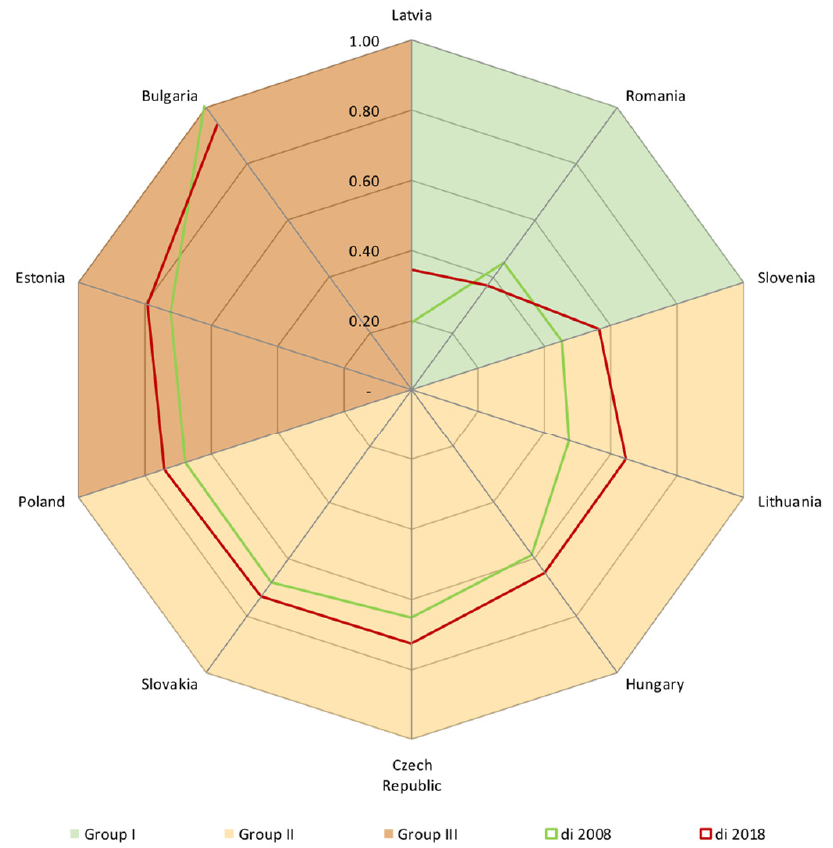
Figure 3. Classification of Central and Eastern European (CEE) countries according to energy transformation based on the synthetic index (di) in 2008 and 2018.